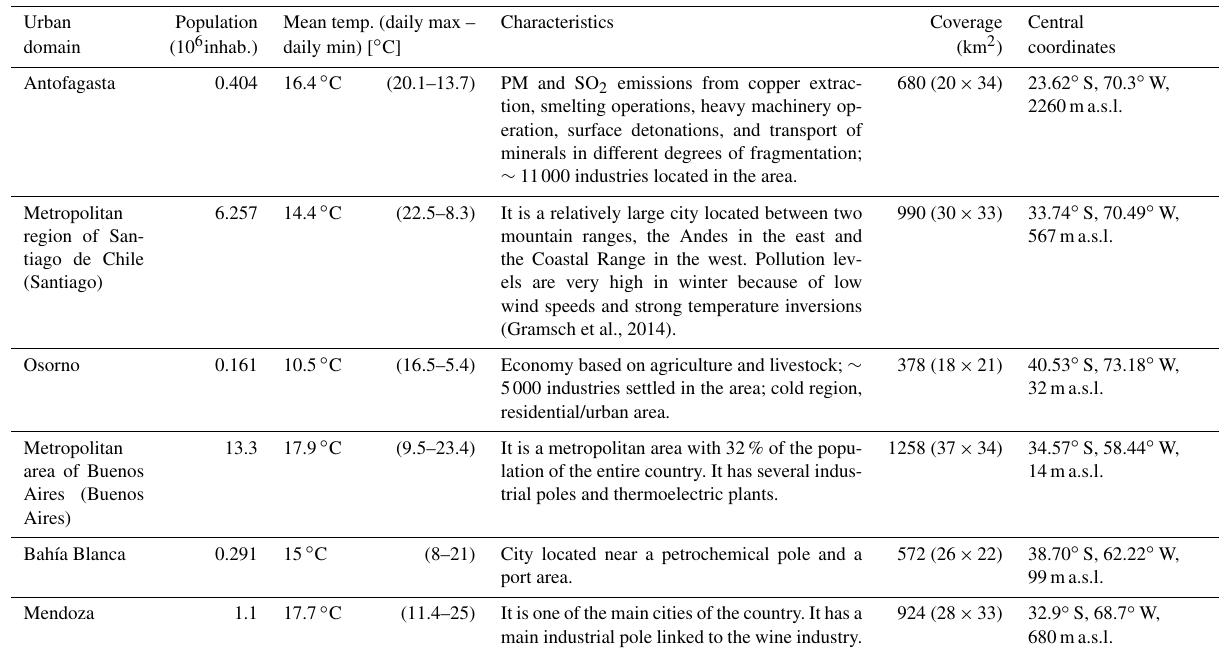
Table A3. Description of the selected domains. Urban Characteristics